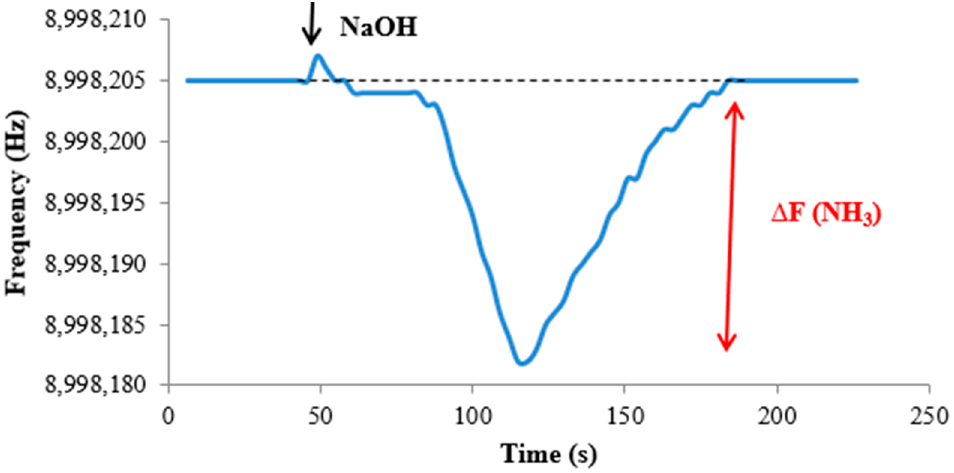
Figure 6. Frequency of the sensor during the analysis of a 30 µg L − 1 ammonium chloride standard solution (dashed grey line shows baseline frequency).